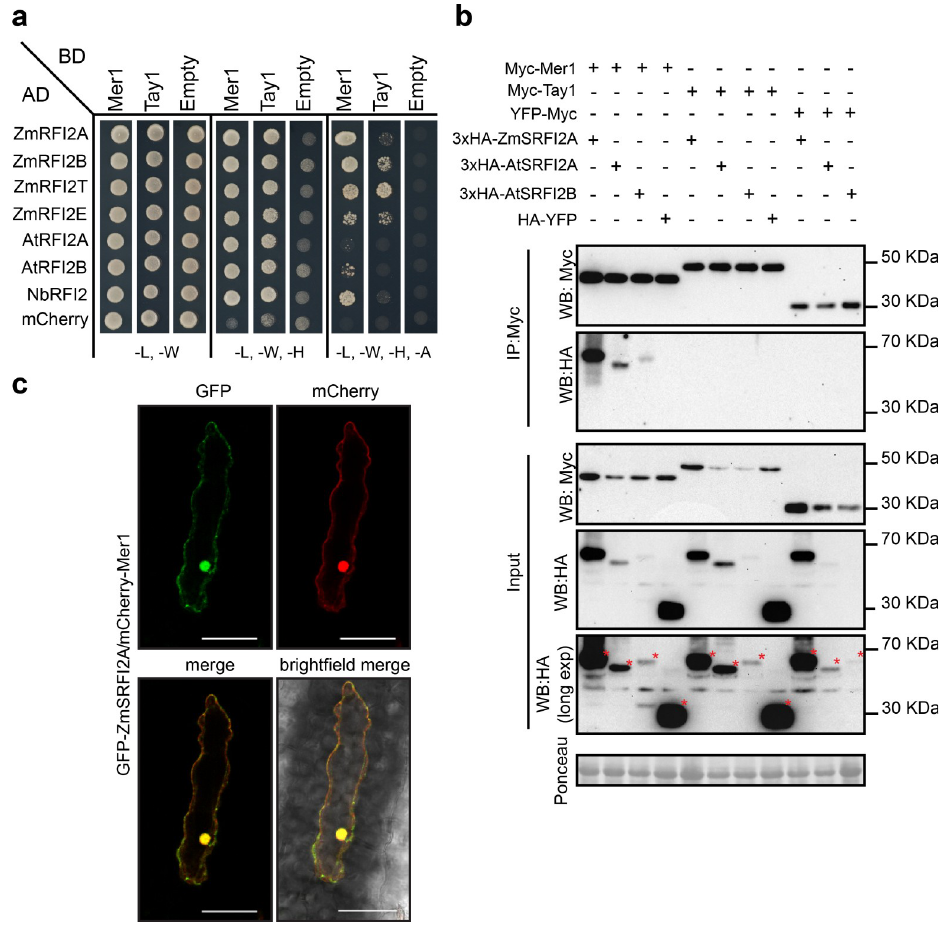
Fig 4. Mer1 interacts with members of the RFI2 family in the plant nucleus. a. Y2H assay showing interaction of Mer1 23-341 and Tay1 28-398 with RFI2 homologs from maize, A . thaliana and N . benthamiana . Yeast strains were grown on SD medium lacking indicated amino acids/nucleotides. Growth in media lacking leu (L) and trp (W) is used as transformation control. Growth in media lacking leu (L), trp (W) and his (H) (intermediate selection) or leu (L), trp (W), his (H) and ade (A) (high stringency selection) indicates protein interaction. b. RFI2 proteins co- immunoprecipitate with Mer1 23-341 but not Tay1 28-398 in planta . Proteins were co-expressed in N . benthamiana by Agrobacterium mediated transformation, total proteins were immunoprecipitated with α Myc magnetic beads (IP: Myc) and blotted with specific antibodies. 3xHA-ZmSRFI2A, 3xHA-AtSRFI2A and 3xHA-AtSRFI2B co- immunoprecipitate with Myc- Mer1 23-341 specifically. Protein loading is indicated by Ponceau staining in the input fraction. ( � ) indicates the full-length proteins. c. mCherry-Mer1 23-341 and GFP-ZmSRFI2A co-localize in the maize nucleus. Proteins were transiently co-expressed in maize epidermal cells by biolistic bombardment. Scale bar = 50 μ m. (S4A and S4C Fig) which we named “stabilized RFI2” (SRFI2). 3xHA-ZmSRFI2A, 3xHA- AtSRFI2A, or 3xHA-SAtRFI2B were co-expressed with Myc-Mer1 or Myc-Tay1 in 23-341 28-398 N . benthamiana . Proteins were extracted and incubated with α -Myc magnetic beads. All three RFI2 homologs tested were able to co-immunoprecipitate in the presence of Myc-Mer1 23-341 but not in the presence of Myc-Tay1 or YFP-Myc (negative control, Fig 4B). Additionally, 28-398 HA-YFP was not co-precipitated in the presence of Myc-Mer1 or Tay1 (Fig 4B). 23-341 28-398 These results show that the interaction between RFI2 homologs and Mer1 is specific. Since we established earlier that Mer1 but not Tay1 targets the host nucleus (Fig 3), we tested whether RFI2 homologs localize to this cellular compartment. We co-bombarded fluo- rescently labeled proteins into the maize epidermis and verified their localization by confocal